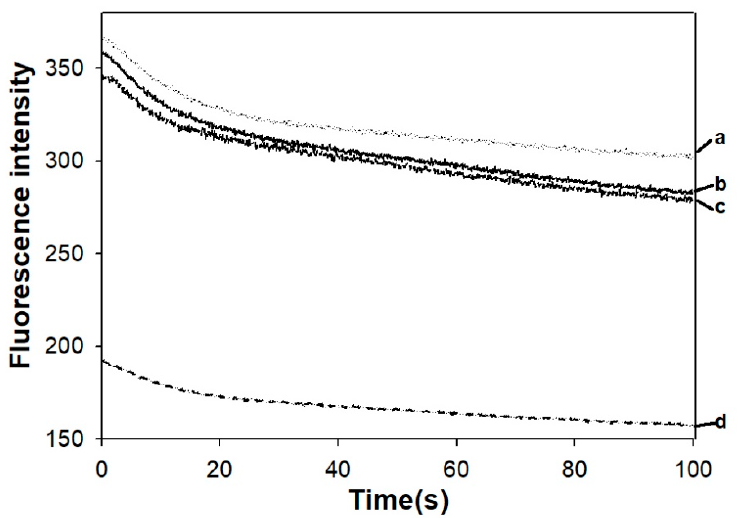
Figure 3. Fluorescence decay of C-Pc with respect to the size of C-Pc aggregate . Fluorescence intensities exposed to 609 nm for excitation during 100 s; Emission intensities were measured every 100 ms; a: Control C-Pc; b: Fraction 1; c: Fraction 2; d: Fraction 3.